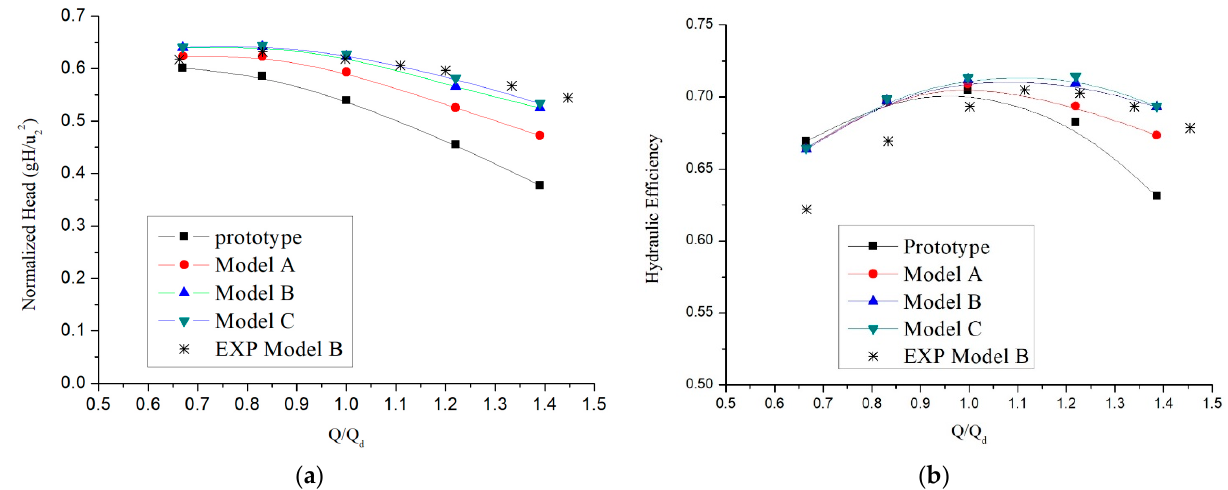
Figure 16. Comparison of the external characteristics: ( a ) head coefficients; ( b ) hydraulic efficiencies.